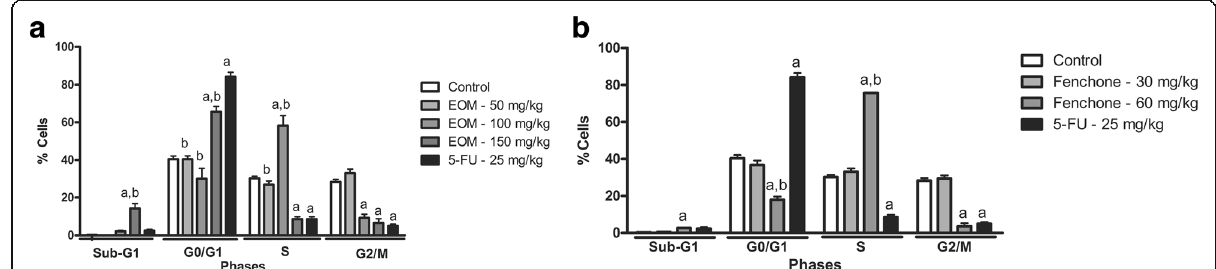
Fig. 3 Percentage of Ehrlich ascites carcinoma cells in different phases of the cell cycle after treatment with 5% Tween 80 solution (tumor control), 5-FU (25 mg/kg), EOM (50, 100 and 150 mg/kg) ( a ) and Fenchone (30 and 60 mg/kg) ( b ). Data presented as mean ± SEM of six animals analyzed by ANOVA followed by Tukey test. a p < 0.05 compared to tumor control. b p <0.05 compared to 5-FU